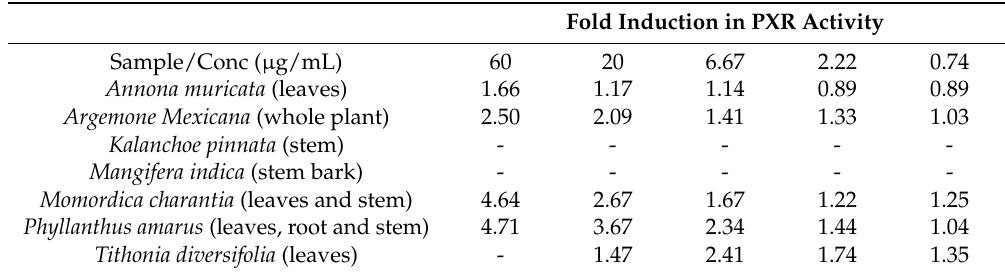
Table 2. The induction of pregnane X receptor activity and the inhibition of P-glycoprotein by the extracts of 7 selected plants.